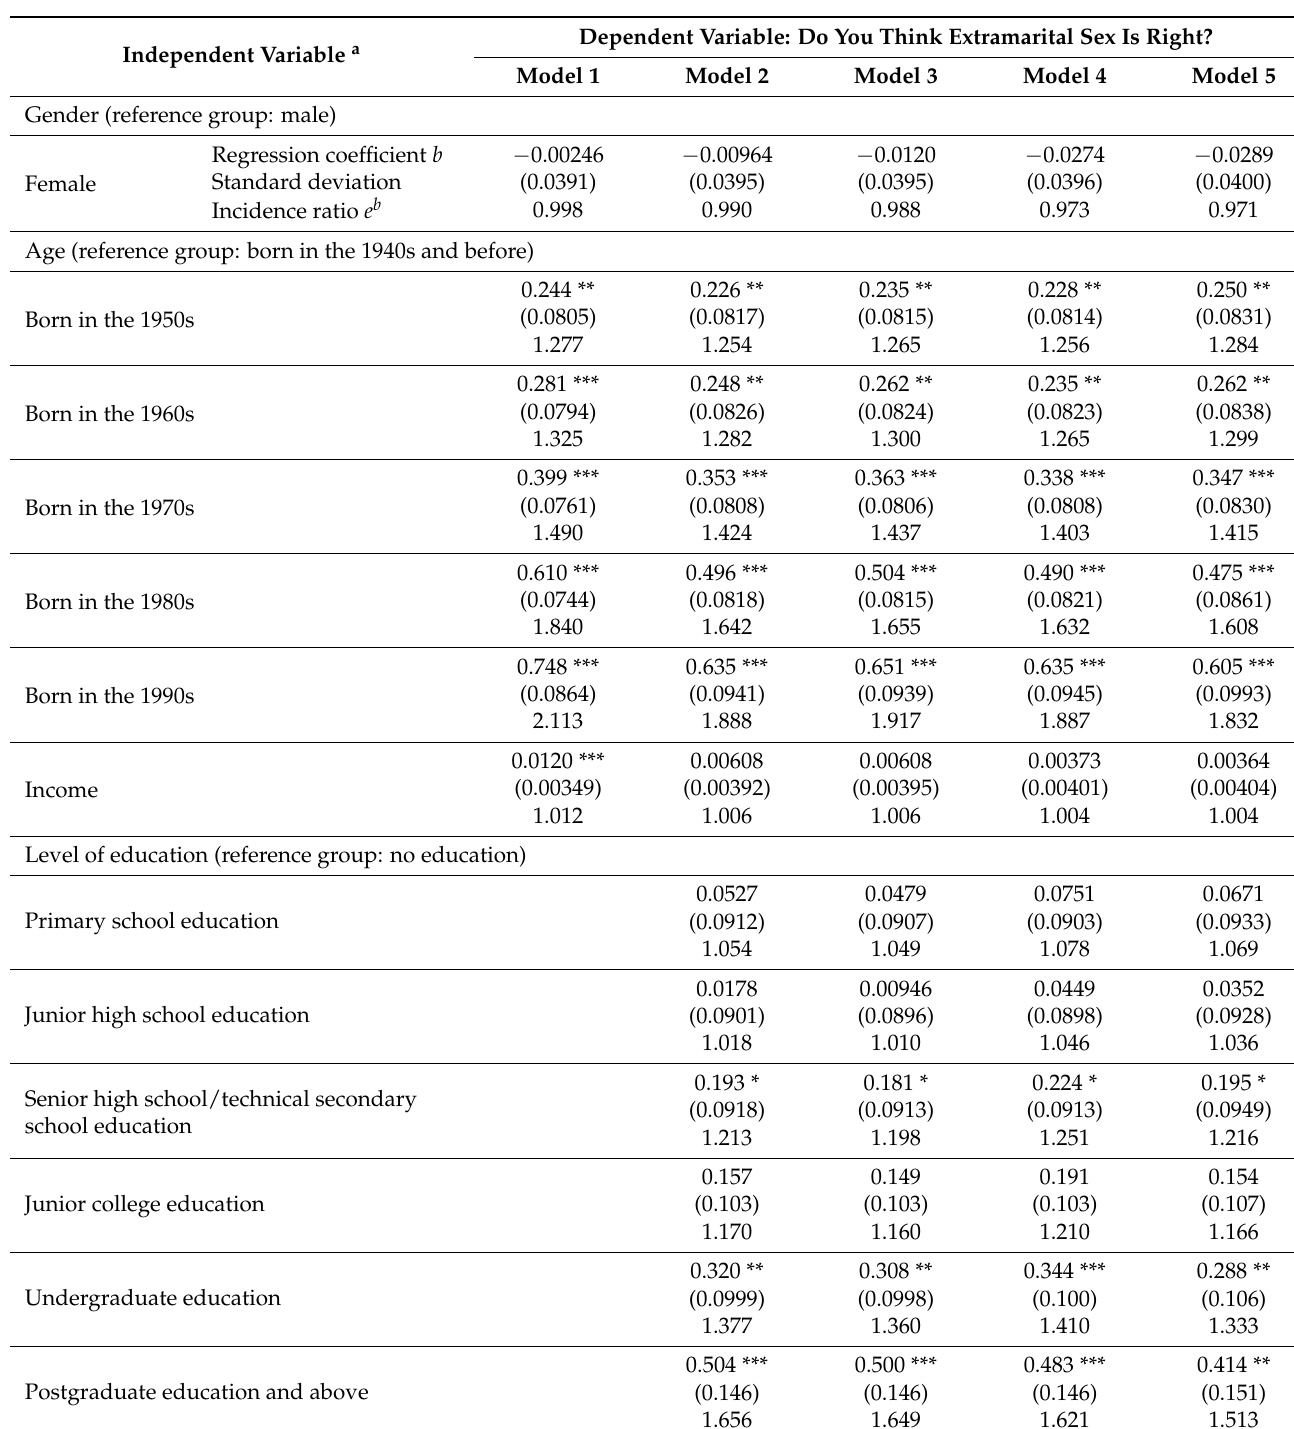
Table 3. Results of zero-inflated Poisson regression